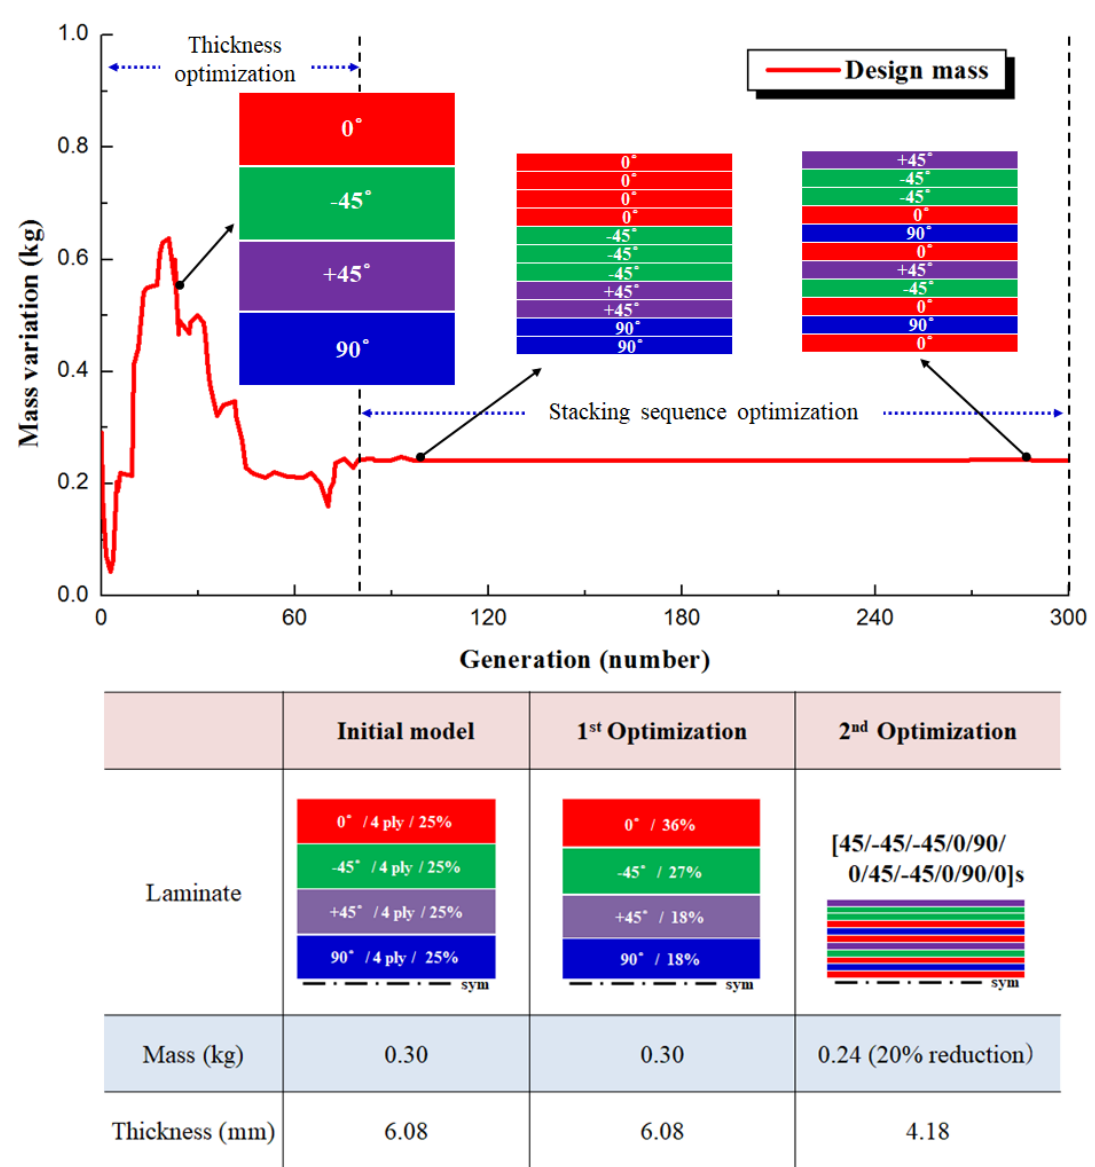
Figure 9. Optimization results by lamination and weight variation.